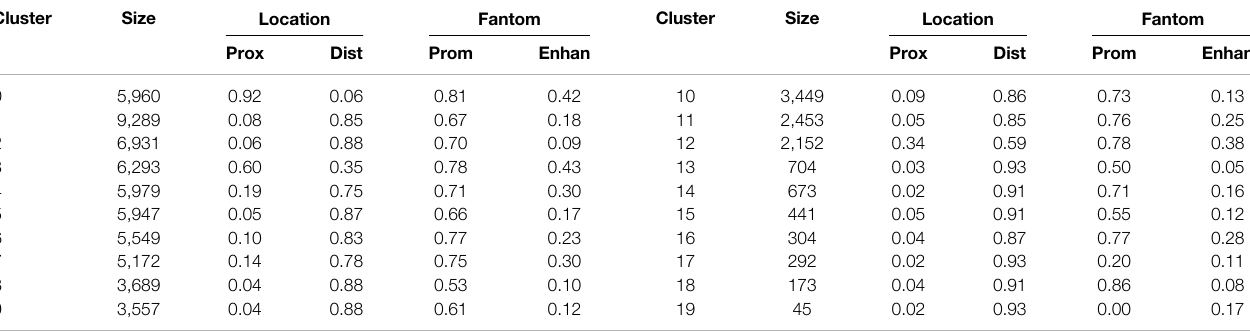
TABLE 2 | Row clusters. Twenty row clusters generated by the Louvain clustering contained 95 % of the non-cell speci fi c loci. Shown are the number of loci in each cluster (size),thefractionofclusterlociwithin500basepair(prox,i.e.proximal)andmorethan3,000basepair(dist,i.e.distal)ofatranscriptionstartsite(TSS),andthefractionof thecluster ’ sproximallocianddistallocithatwereintheFANTOMdatabaseofpromoters(prom)andactiveenhancers(enhan).Rowclusters0and3hadlocilargelyproximal to TSS, while all other clusters were largely composed of loci distal to TSS. In most clusters, greater than 70 % of the proximal loci and 10 – 40 % of distal loci were labeled as promoters and active enhancers,